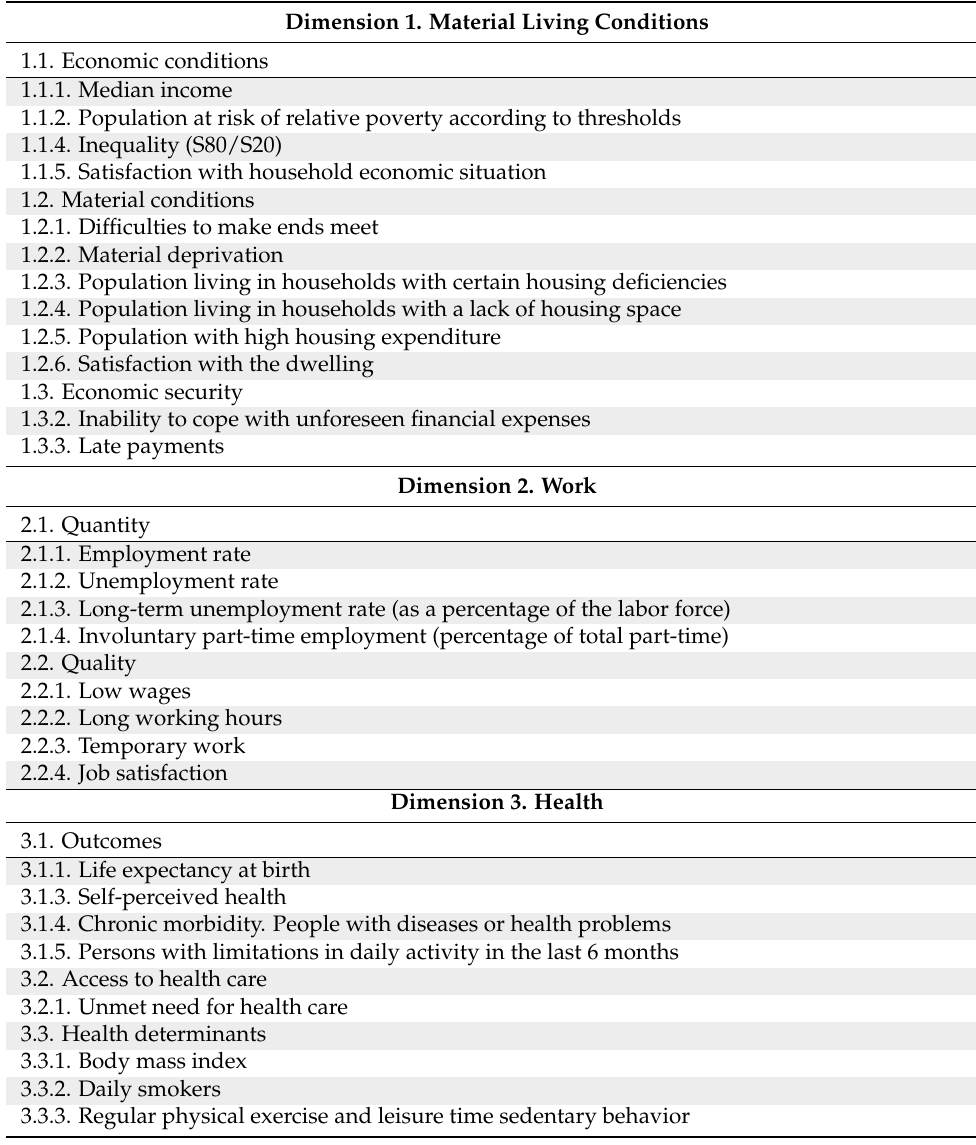
Table A1. The 55 indicators used by